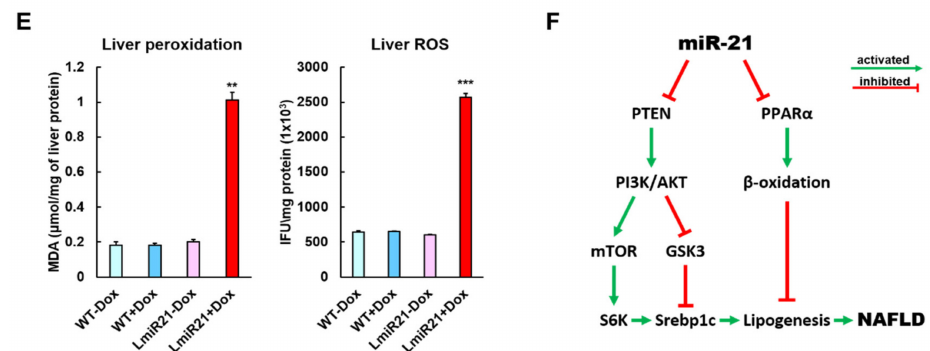
Figure 3. MiR-21 targets ptenb and pparaa levels in hepatocytes, which leads to nonalcoholic fatty liver disease (NAFLD) progression. ( A ) Schematic alignment between the mature miR-21 seed sequence (red) and (1) ptenb , (2) pparaa mRNA target sequence (blue) at the 3 (cid:48) -UTR. Perfect matches are indicated by a line, and G:U pairs by a colon. (left). Whole mount in situ hybridization (ISH) assays demonstrate that miR-21 significantly represses in vivo expression of (1) ptenb and (2) pparaa mRNA in AmiR + Dox, compared to that in AmiR-Dox (right). Scale bar:1 mm. ( B ) MiR-21 expression in the livers of WT ± Dox and LmiR21 ± Dox at 4 mpf. mRNA expression levels of ptenb and pparaa mRNA liver of WT ± Dox and LmiR21 ± Dox at 4 mpf. ( C ) Western blot images (left) and quantitative data (right) of Ptenb, Pparaa and p-Akt in the livers of WT ± Dox and LmiR21 ± Dox at 4 mpf. ( D ) Increased expression of lipogenic genes in response to pten suppression was greater in LmiR21 + Dox than controls ( n = 3). Decreased expression of genes involved in fatty acid β -oxidation in response to pparaa suppression was greater in LmiR21 + Dox than controls ( n = 3). ( E ) Levels of hepatic oxidative stress, MDA, and H 2 O 2 in hepatic mitochondria is also greater in LmiR21 + Dox than in the controls ( n = 3). ( F ) Bilateral-factorial effects of miR-21 in NAFLD acceleration. Statistically significant differences from LmiR21 − Dox were denoted by * ( p < 0.05), ** ( p < 0.01) and *** ( p < 0.001) for panels